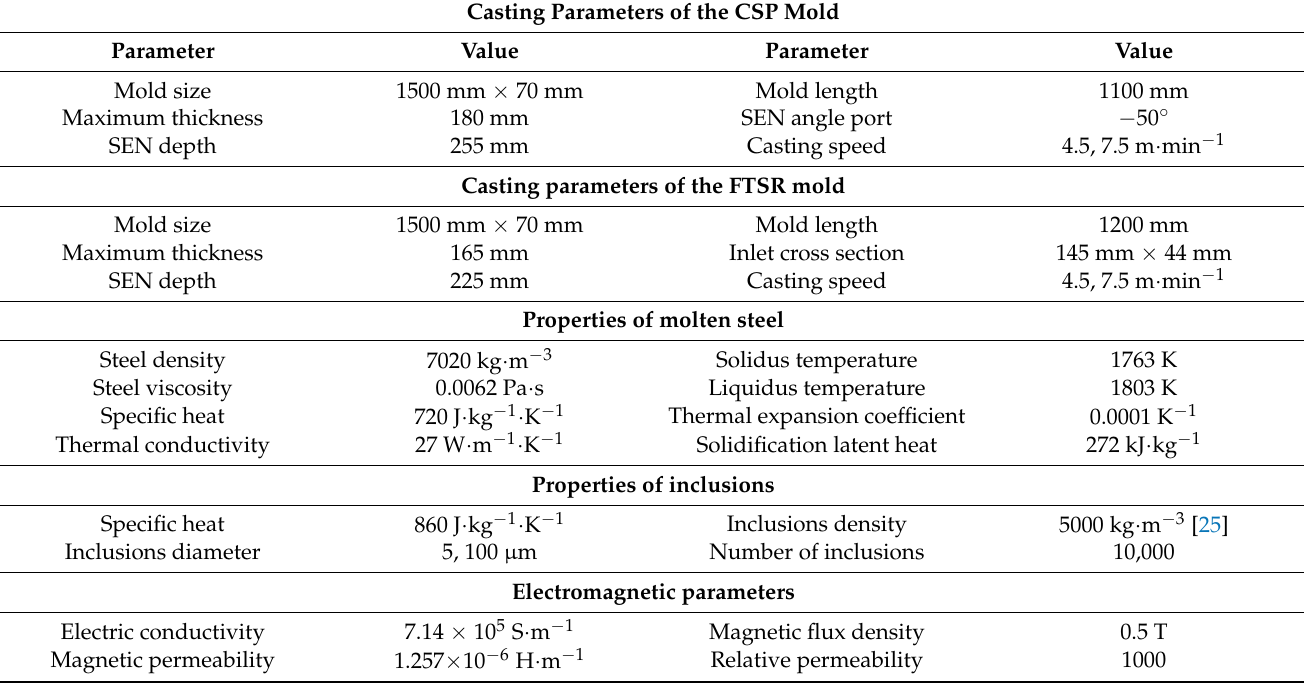
Table 1. Parameters of the CSP and FTSR